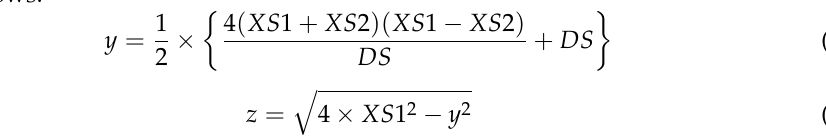
Figure 8. Variation of the extreme point when a magnetic dipole was fed on y = 50, z = 100.